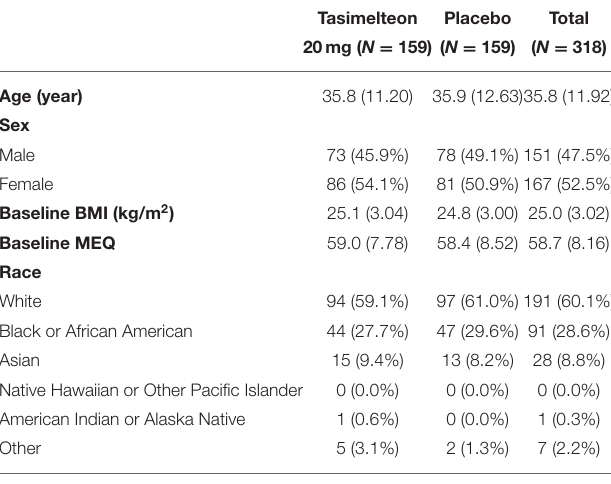
TABLE 1 | Baseline characteristics for the ITT